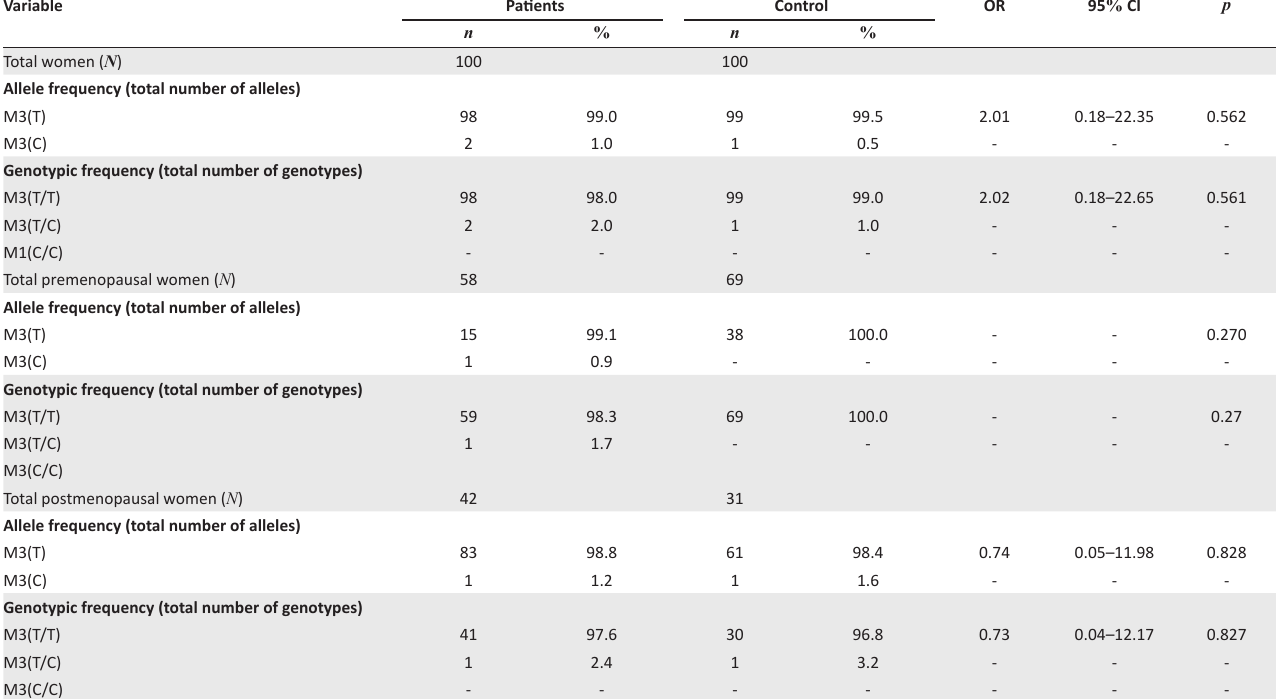
TABLE 4: Allelic and genotypic frequencies of Cytochrome P-4501A1 M3 allele for Sudanese female breast cancer patients and control group with menopausal ages. Variable Patients